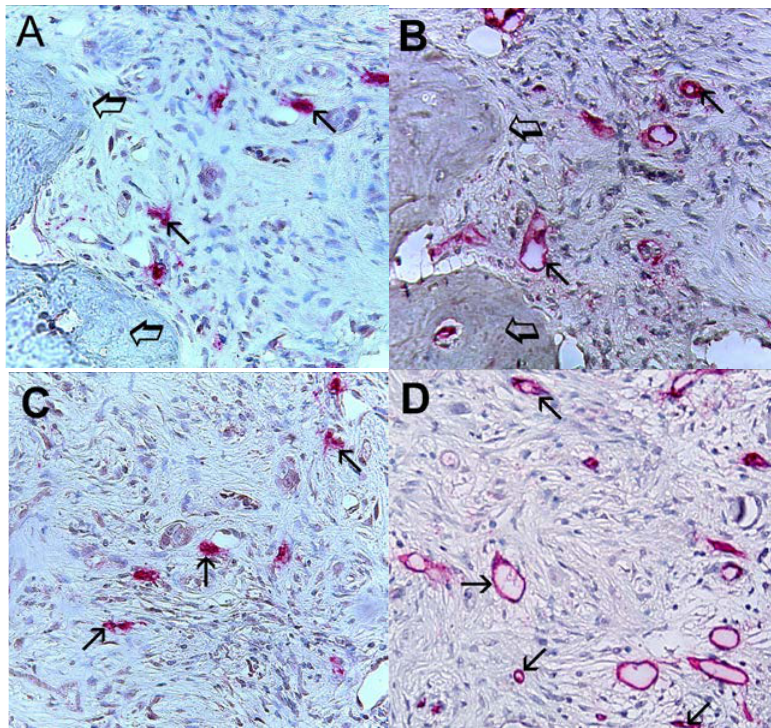
Figure 5. ( A , C ) Bone metastases from gastric cancer tissue sections. Small arrows indicate single red immunostained mast cells. Large arrows indicate bone tissue. Intermediate magnification: 400×; ( B , D ) Bone metastases from gastric cancer tissue sections. Small arrows indicate single red immunostained microvessels; note the small lumen. Large arrows indicate bone tissue. Intermediate magnification: